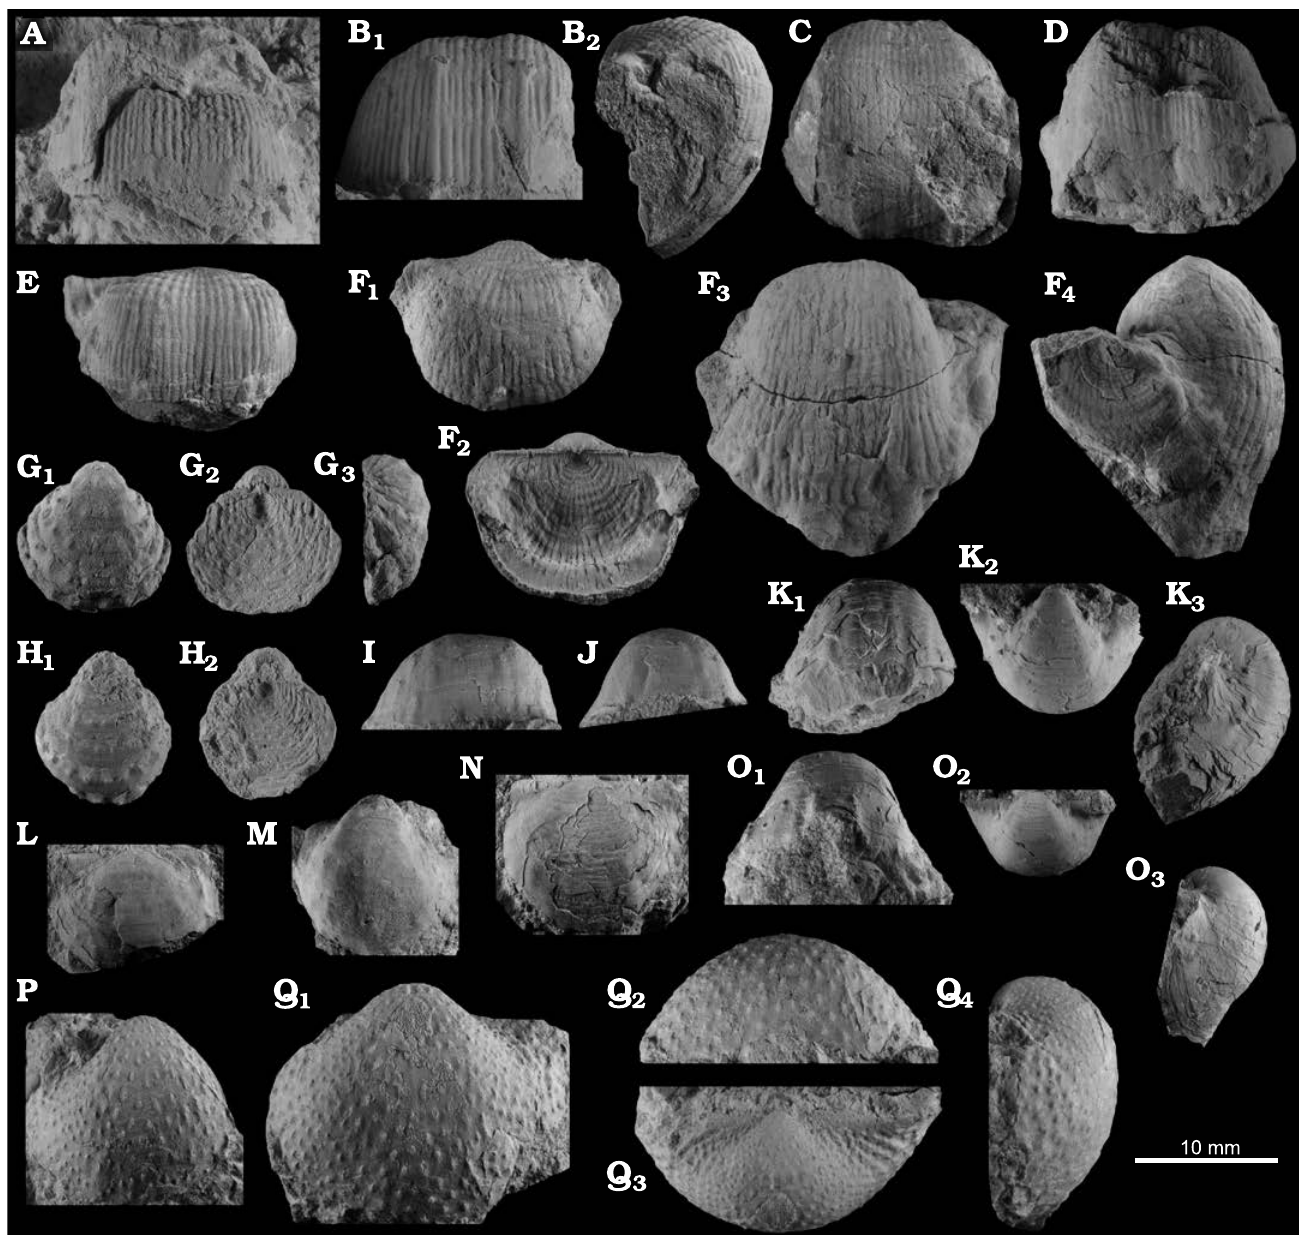
near Matlock (locality WI1; see Fig. 2), Derbyshire, UK. A – E . Alitaria aff. triquetra (Muir-Wood, 1928). A . MPUM11860 (RCC2-13) in anterior view. B . MPUM11861 (RCC12-2) in anterior (B 1 ) and lateral (B 2 ) views. C . MPUM11862 (RCC60-2) in antero-ventral view. D . MPUM11864 (RCC2-40), ventral valve in antero-ventral view. E . MPUM11866 (RCC128-13), dorsal valve in anterior view. F . Eomarginiferina trispina Brunton, 1966, MPUM11869 (WI1- 31) in ventral (F 1 ), dorsal (F 2 ), anterior (F 3 ), and lateral (F 4 ) views. G , H . Overtonia fimbriata (Sowerby, 1824). G . MPUM11870 (RCK15-1b) in ventral (G 1 ), dorsal (G 2 ), and lateral (G 3 ) views. H . MPUM11871 (RCK15-53) in ventral (H 1 ) and dorsal (H 2 ) views. I . Avonia sp., MPUM11872 (RCC128-4a), ventral valve in anterior view. J – N . Quasiavonia aculeata (Sowerby, 1814). J . MPUM11873 (RCC32-28a) in anterior view. K . MPUM11874 (RCC49- 28) in anterior (K 1 ), postero-ventral (K 2 ), and lateral (K 3 ) views. L . MPUM11877 (RCC49-24) dorsal valve interior and external cast. M . MPUM11875 (RCK17-2) in ventral view. N . MPUM11878 (RCK15-51) dorsal valve interior. O . ? Quasiavonia sp., MPUM11883 (RCC3-11); anterior (O 1 ), posterior (O 2 ), and lateral (O 3 ) views. P , Q . Krotovia spinulosa (Sowerby, 1814). P . MPUM11884 (RCC54-17b) in ventral view. Q . MPUM11885 (RCC68-2) in ventral (Q 1 ), anterior (Q 2 ), posterior (Q 3 ), and lateral (Q 4 )